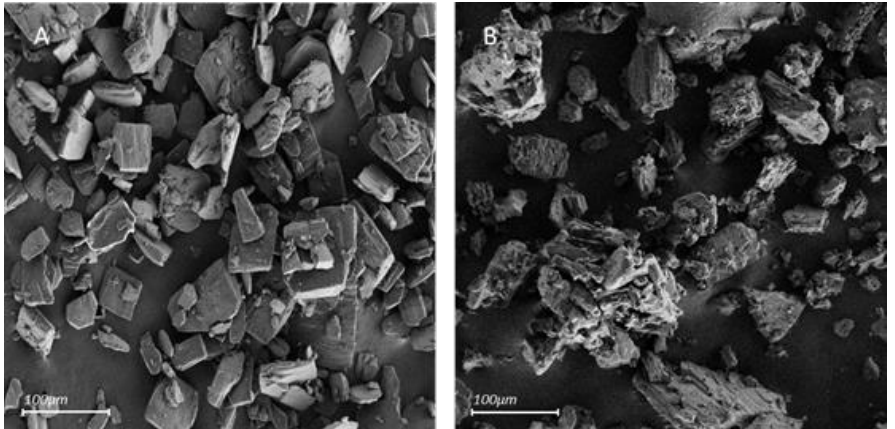
Figure 4. Scanning electron micrographs of β -CD ( A ) and the powder recovered after extraction of Tyr from a 100 mM aqueous solution (10:1 β -CD/Tyr molar ratio) ( B ) (Magnification: ×140).